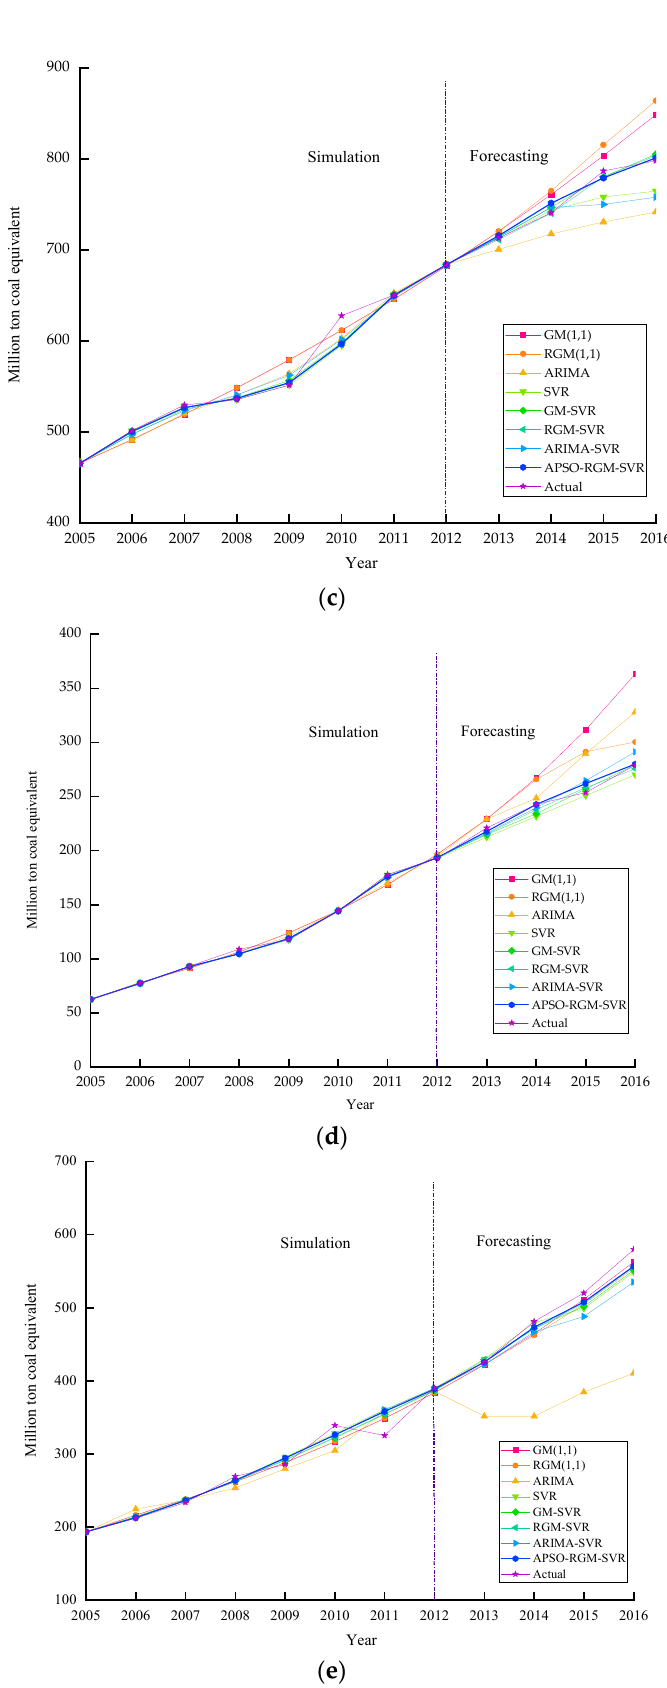
Figure 8. The simulation and forecasting results for ( a ) the total energy consumption; ( b ) coal; ( c ) oil; ( d ) natural gas; and ( e ) hydro, nuclear, and wind